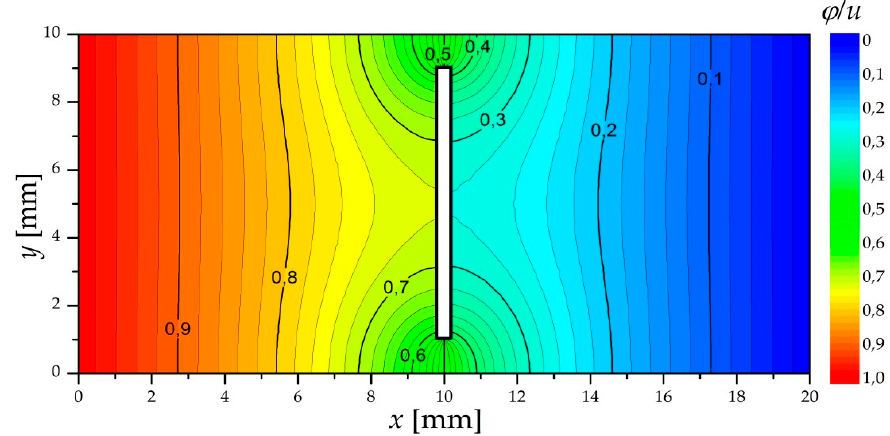
Figure 8. Potential distribution for an infinitely thin crack calculated using the numerical method for u = 1 V, θ = 90 ◦ , a = 8 mm.